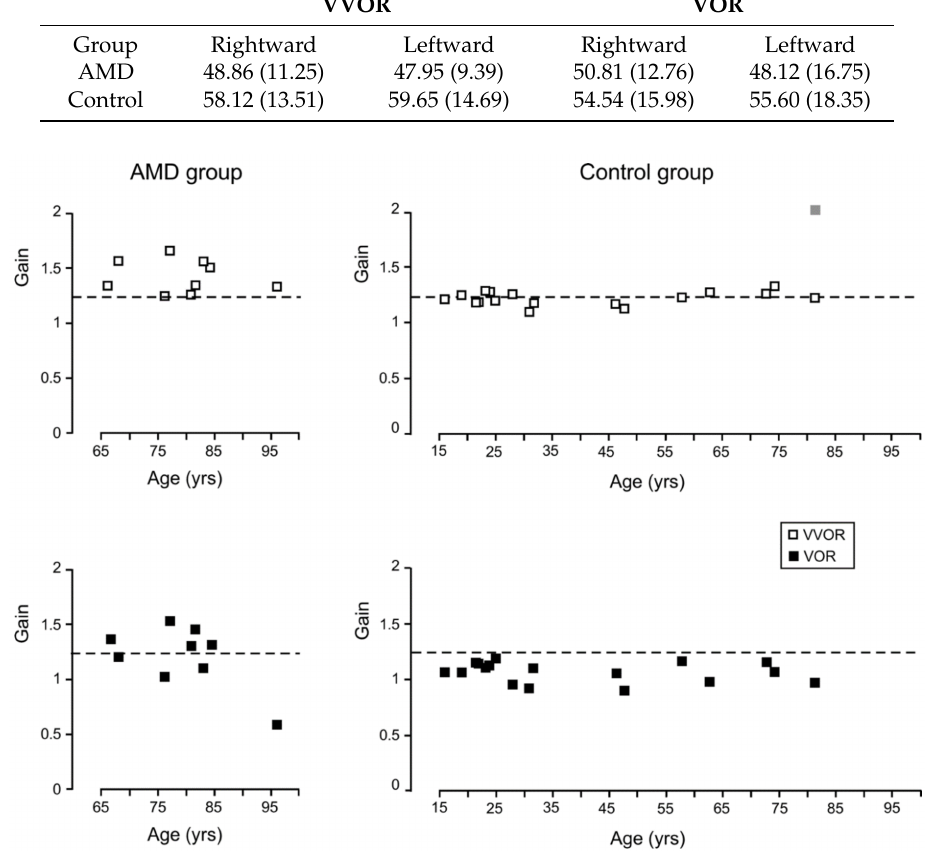
Figure 4. Mean gain values (average of rightward and leftward eye movements) obtained from the eye’s peak velocity between saccades. All the data were obtained from the participants’ right eye with the exception of control participant C17 who reported diplopia and whose left eye datum is shown as a black open square and the right eye’s as a grey filled square. For all the other participants in both the control and AMD groups, there were no significant differences in gain between the two eyes. The dashed lines show the expected average gain of 1.17 (Equation